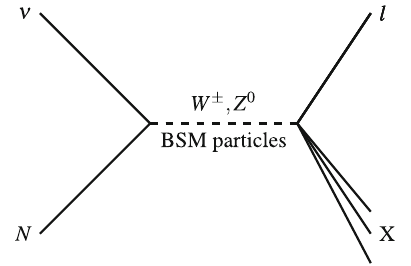
dard model (BSM) particle; Right: in presence of BH production ν N → BH → lX . Here l is the charged or neutral lepton and X is the shower